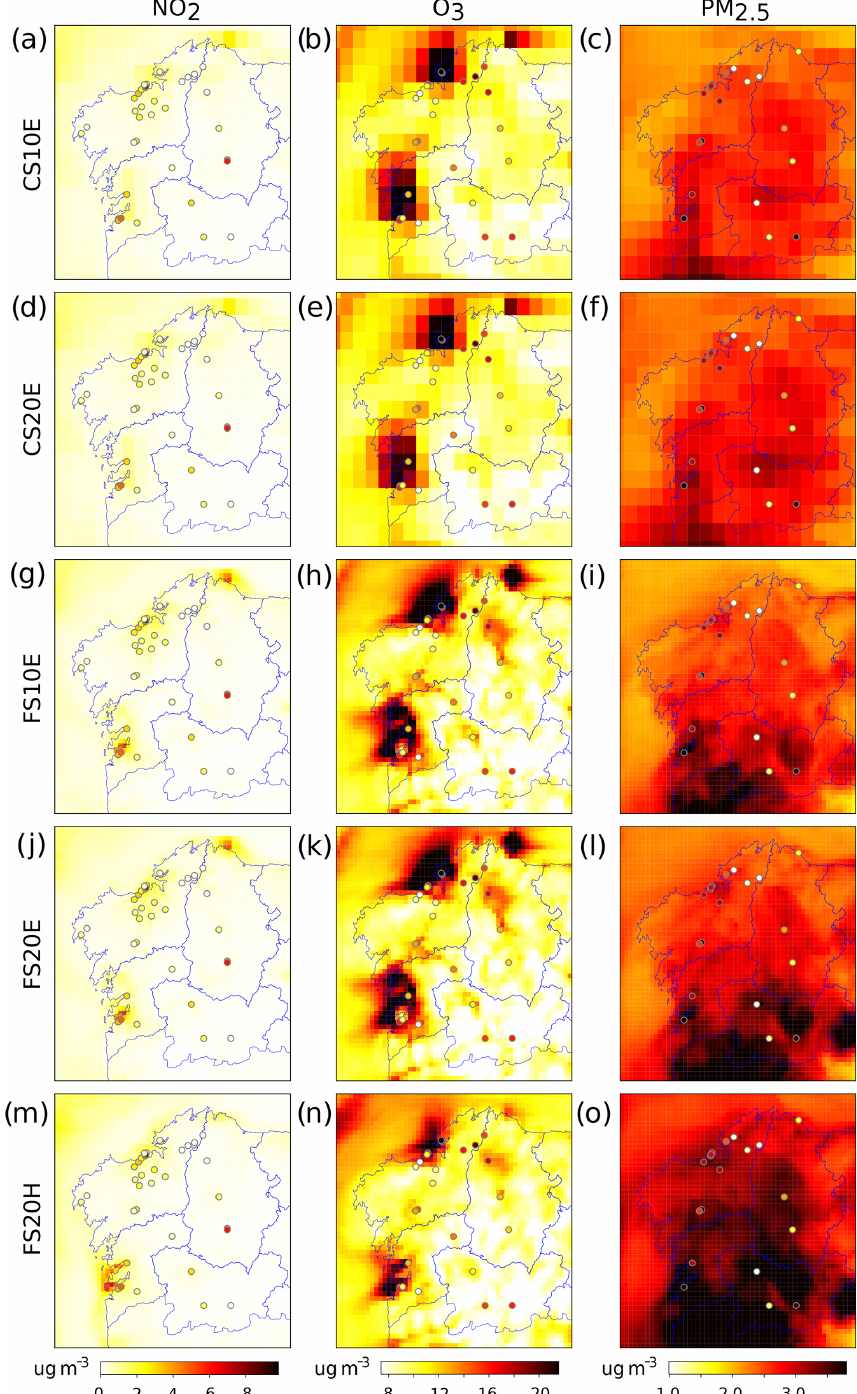
Figure 7. Observed (dots) vs. modeled (underlying pattern) temporal standard deviation values for the daily minimum concentrations of NO 2 , O 3 and PM 2 . 5 , as well as the five experiments marked with an asterisk in Table 3, all run with the SAPRC mechanism. The spatial verification results for each panel are provided in Table